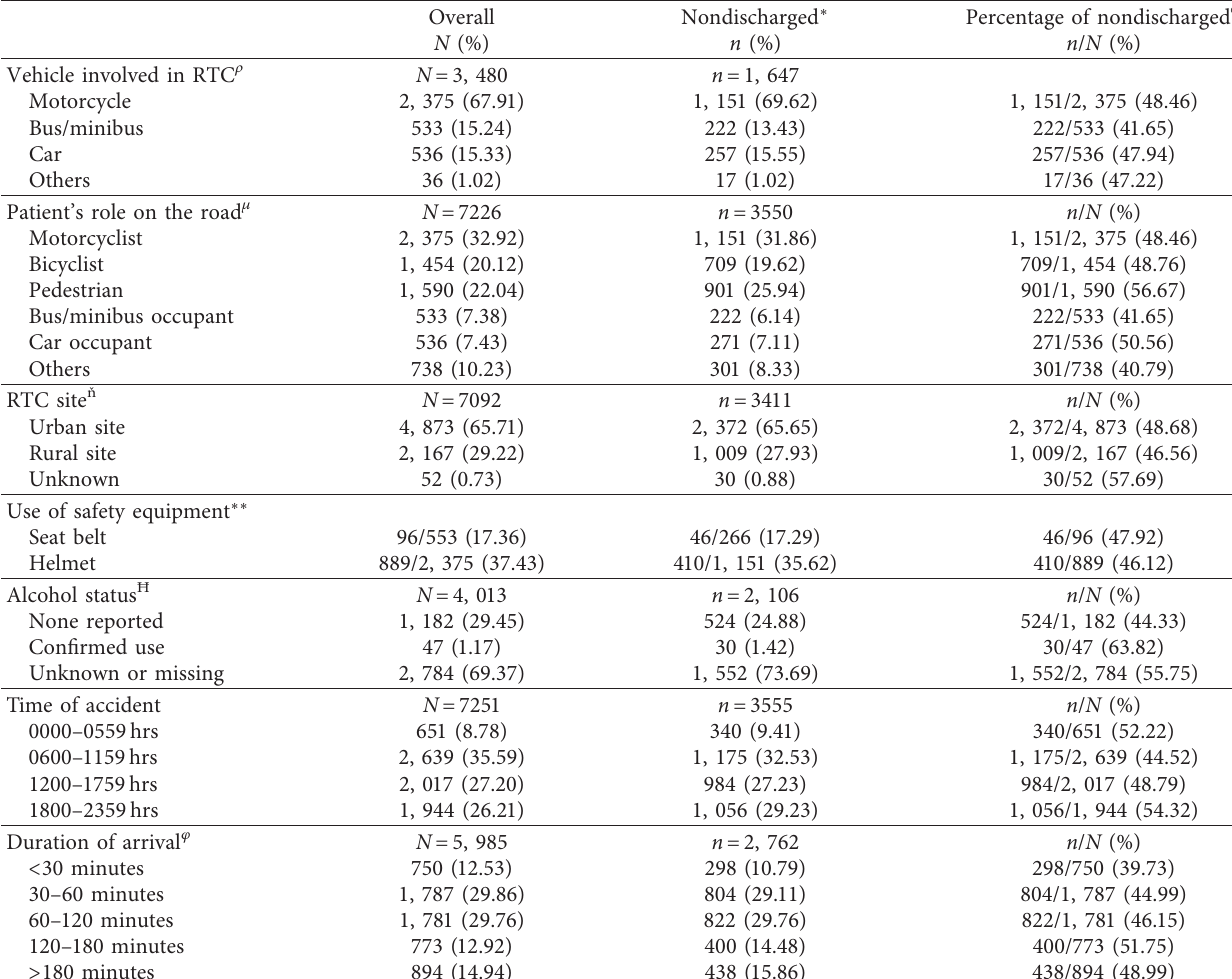
Table 2: Description of nature of RTI with risk factors for serious